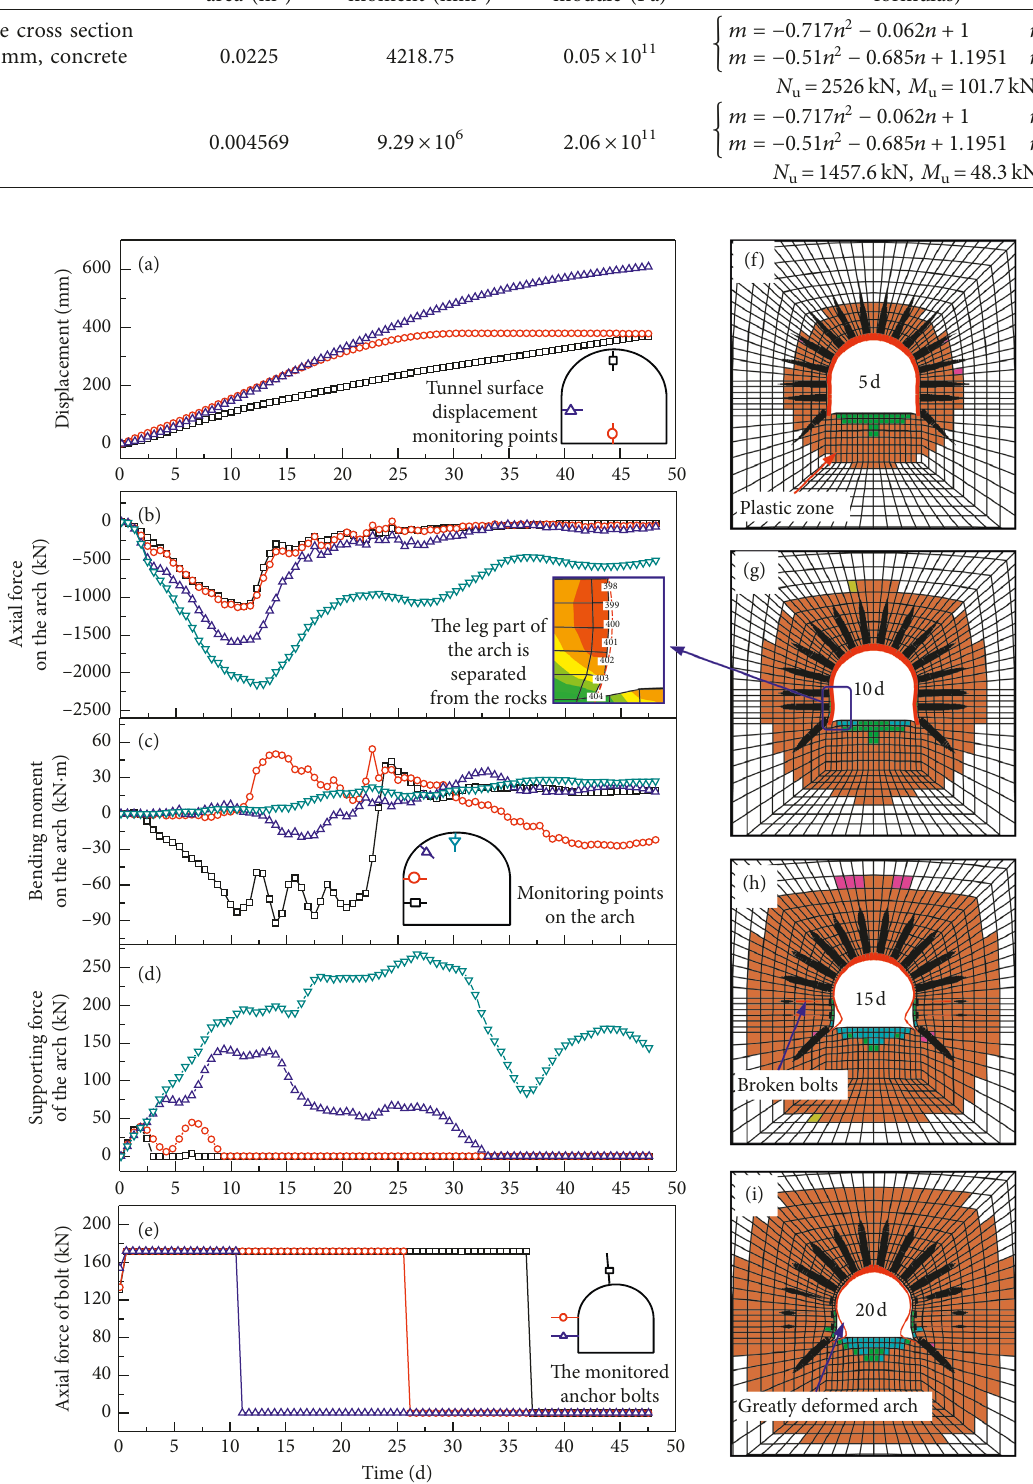
Figure 3: Result diagrams of Scheme 4 (ground stress 15MPa). (a) ∼ (e): Development curves of roadway displacement, arch axial force, arch bending moment, arch supporting force, and rock bolt axial force, respectively; (f) ∼ (i): diagrams of plastic zone and supporting structure inner force at the 5 th day, 10 th day, 15 th day, and the 20 th day, respectively. (Supporting arches and rock bolts are presented as the axial force diagrams; the thicker the line, the greater the axial force. When the line thickness of the bolt axial force diagrams is 0, it means the bolts are